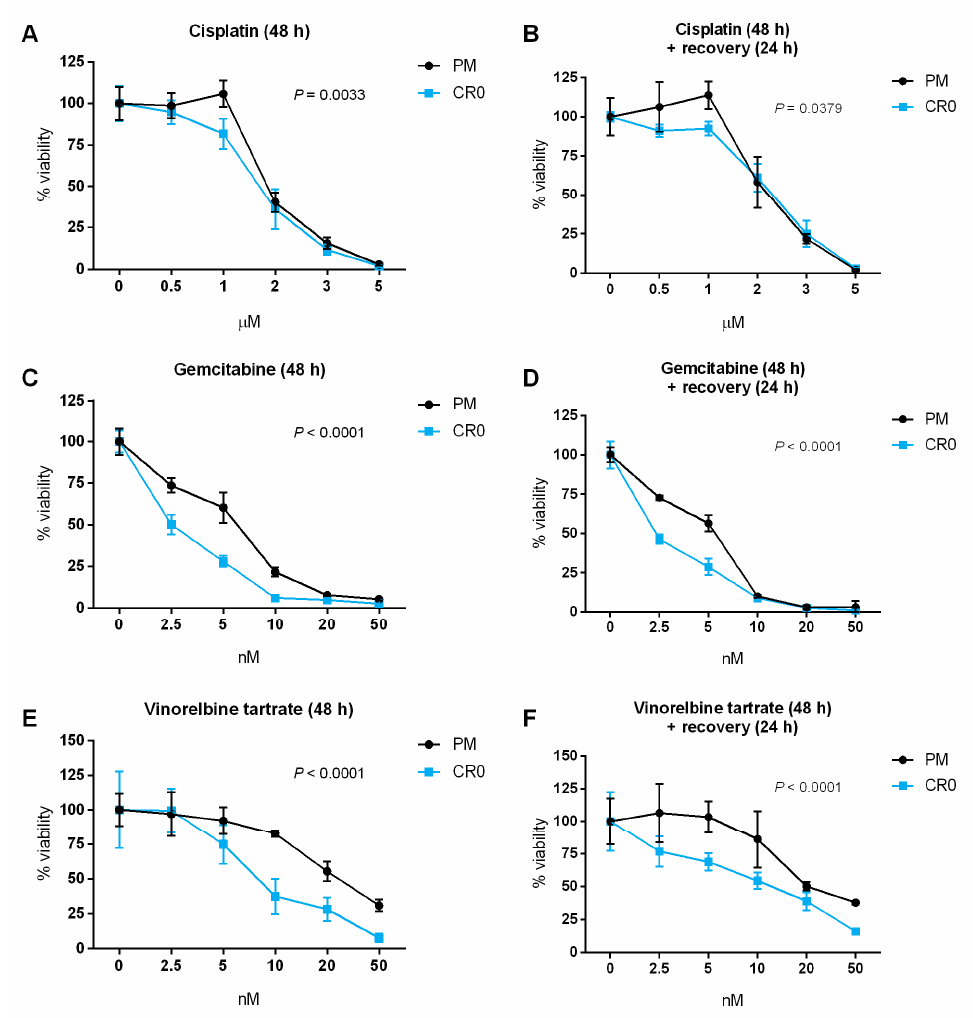
Figure 5. Cell viability of PM and CR0 cells exposed to selected chemotherapeutic drugs. Three drugs were tested: ( A , B ) cisplatin, ( C , D ) gemcitabine, and ( E , F ) vinorelbine tartrate. Cells were treated with various concentrations of the above chemotherapeutic drugs for 48 h and their viability was measured by MTS assay (A,C,E) directly or (B,D,F) after a 24 h recovery period. Results are representative of at least three independent experiments with a similar survival trend. The percentage of viability was plotted as 100% for untreated CR0 or PM controls. Error bars represent mean ± SD of at least four technical replicates. Two-way ANOVA was used to determine significant di ff erences between CR0 and PM by comparing the means at each concentration point, and p ≤ 0.05 was considered statistically